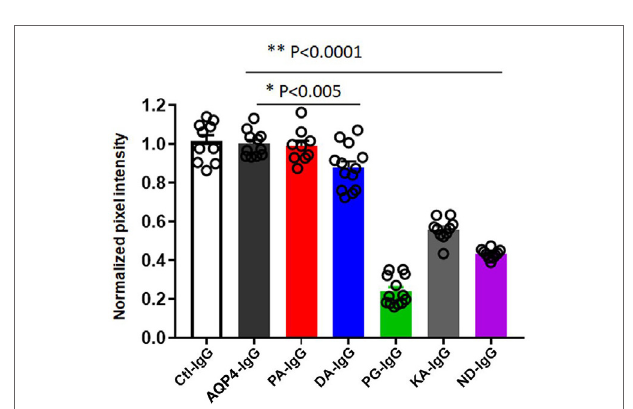
FigUre 3 | Effect of mutations of AQP4–IgG on transport across the placenta. Infrared labeled AQP4–IgG and its isotype control antibody (Ctl-IgG) as well as the Fc-mutated PA-IgG show an equal degree of transplacental transport in the embryo (a) . DA-IgG shows modestly diminished transport (B) . KA-IgG, ND-IgG, and PG-IgG have severely impaired transplacental transport (c) . Each antibody was tested in 2 litters at a concentration of 60